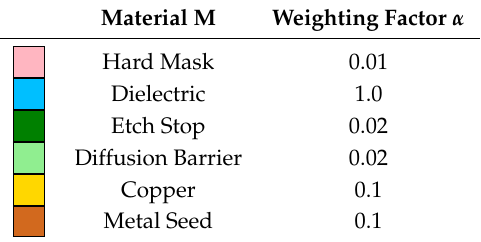
Figure 6. Simulation geometry used in our study (see Figure 2g). Material regions are encoded using colors according to Table 1. Table 1. Normalized weighting factors corresponding to the etch rates for the different materials in our simulation.